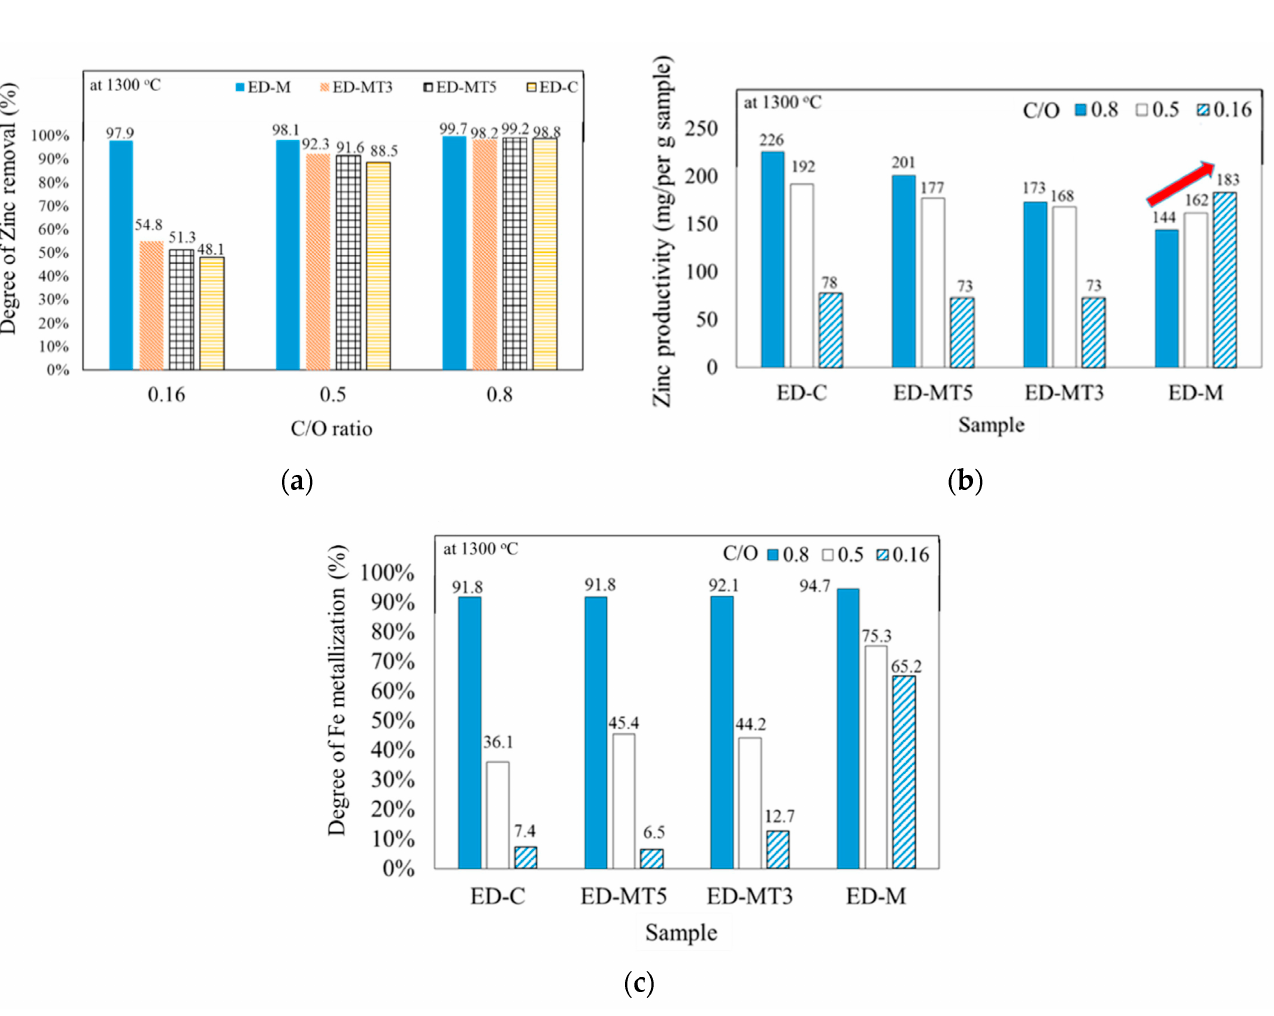
Figure 4. Effect of C/O ratio on the reduction of oxides containing Zn and Fe in EAFD when heated to 1300 ◦ C; ( a ) Degree of Zn removal of samples with different C/O ratios; ( b ) Zn productivity, defined as Zn removal per gram of pellet sample (including EAFD and reducing agent), at different C/O ratios; ( c ) Degree of Fe metallization at different C/O